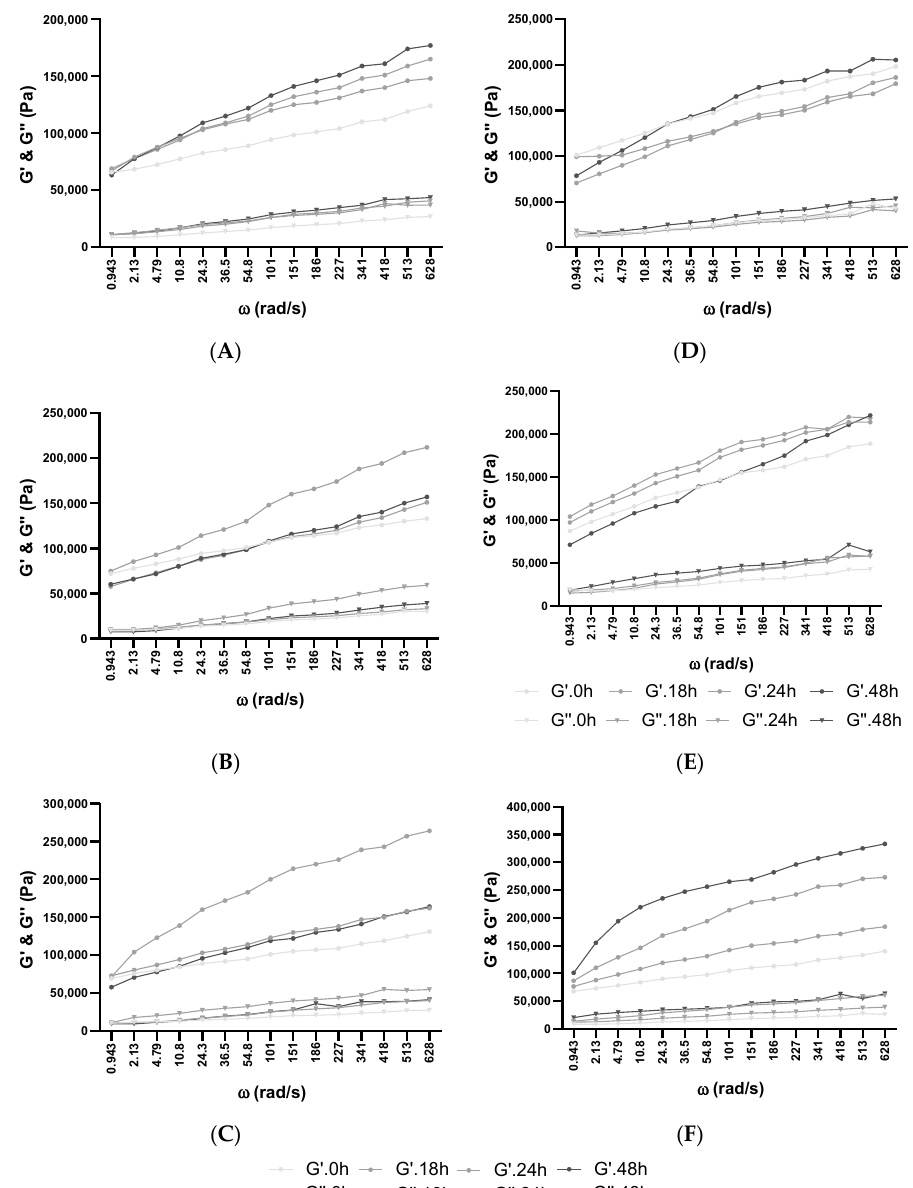
Figure 2. Influence of fermentation and frozen storage with BB-12 in fresh samples—( A ) 100% WF, ( B ) 1% Glu, and ( C ) 1% XOS—and after frozen storage—( D ) 100% WF, ( E ) 1% Glu, and ( F ) 1% XOS. Angular frequency ( ω ), storage modulus (G’), loss modulus (G’’).